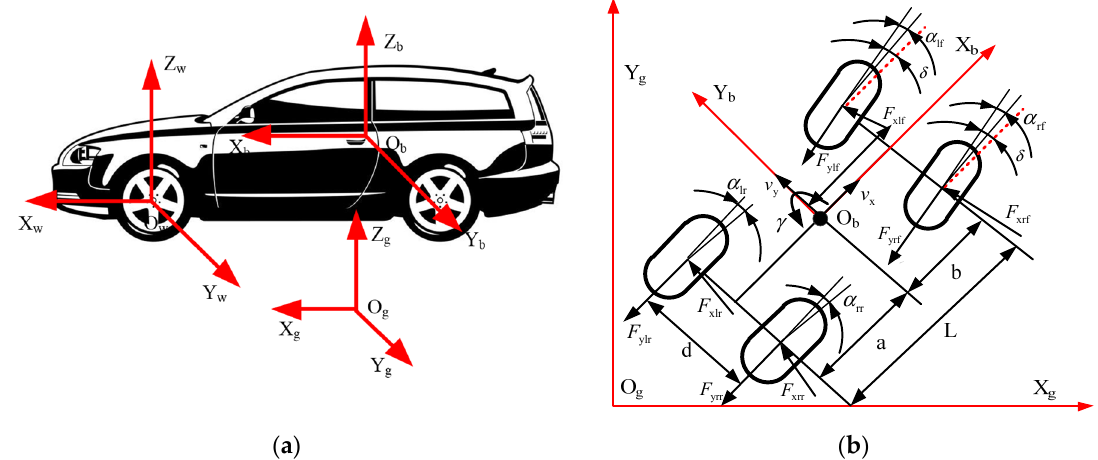
Figure 4. Schematic diagram of seven-degree-of-freedom vehicle model of four-wheel vehicle. (a) Seven degrees of freedom vehicle model. (b) Seven degrees of freedom plane motion.